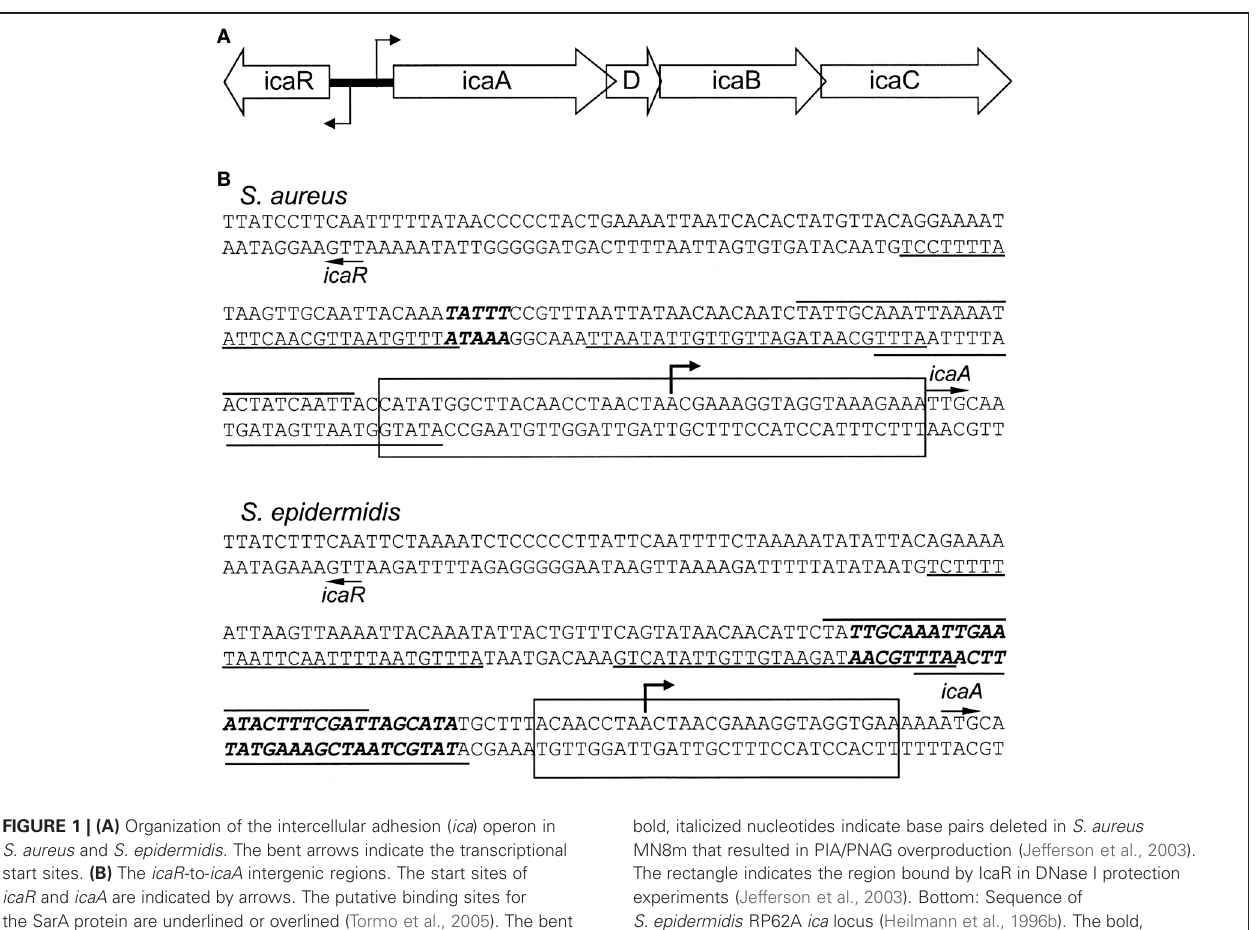
FIGURE 1 | (A) Organization of the intercellular adhesion ( ica ) operon in S. aureus and S. epidermidis . The bent arrows indicate the transcriptional start sites. (B) The icaR -to- icaA intergenic regions. The start sites of icaR and icaA are indicated by arrows. The putative binding sites for the SarA protein are underlined or overlined (Tormo et al., 2005). The bent arrow indicates the icaADBC transcription start site determined for S. epidermidis RP62A; (Heilmann et al., 1996b; Mack et al., 2000). Top: Sequence of the S. aureus NCTC 8325 ica locus (Gillaspy et al., 2006). The